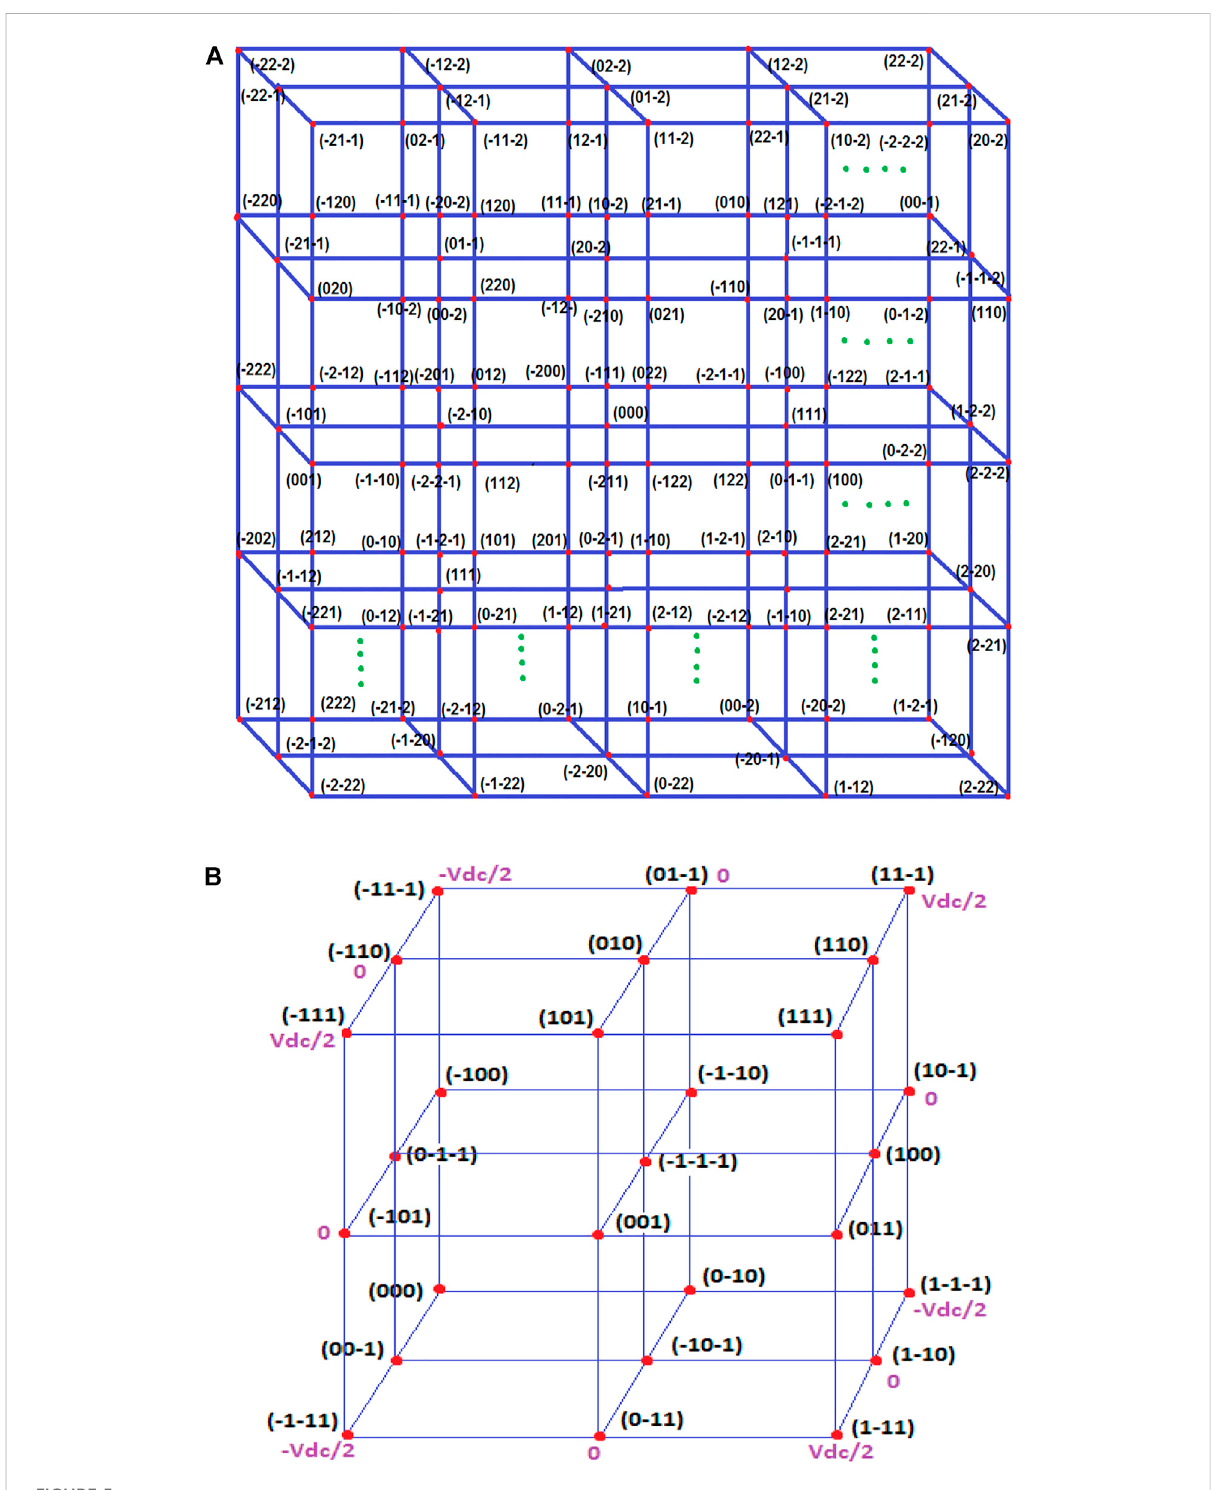
FIGURE 5 Representation of 3D-SVPWM (A) n-phase (B)